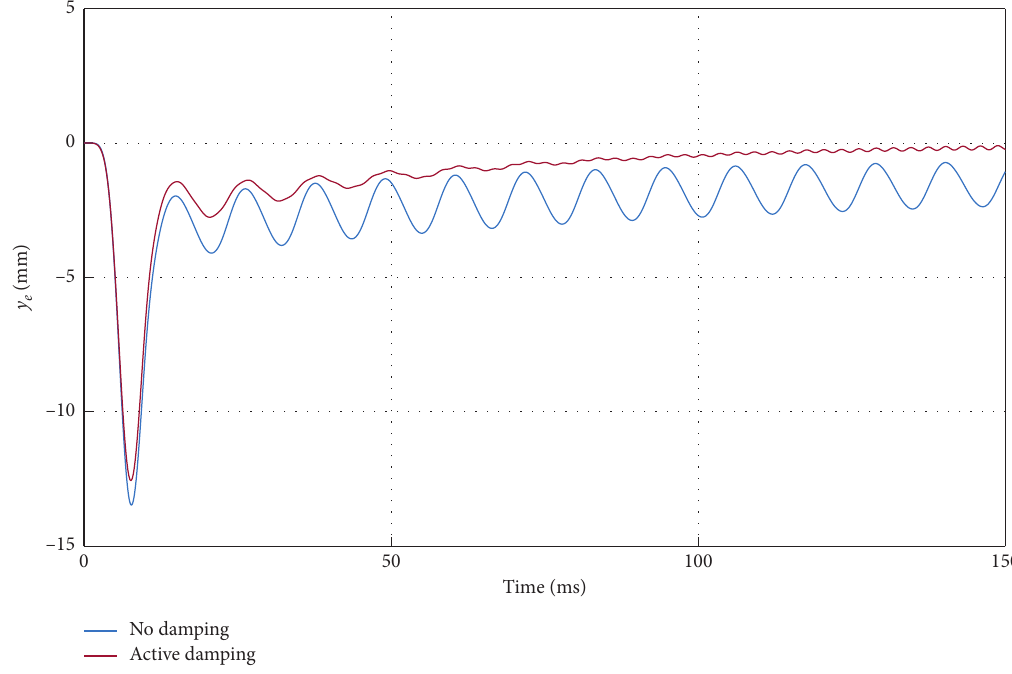
Figure 7: Y -directional movement of the